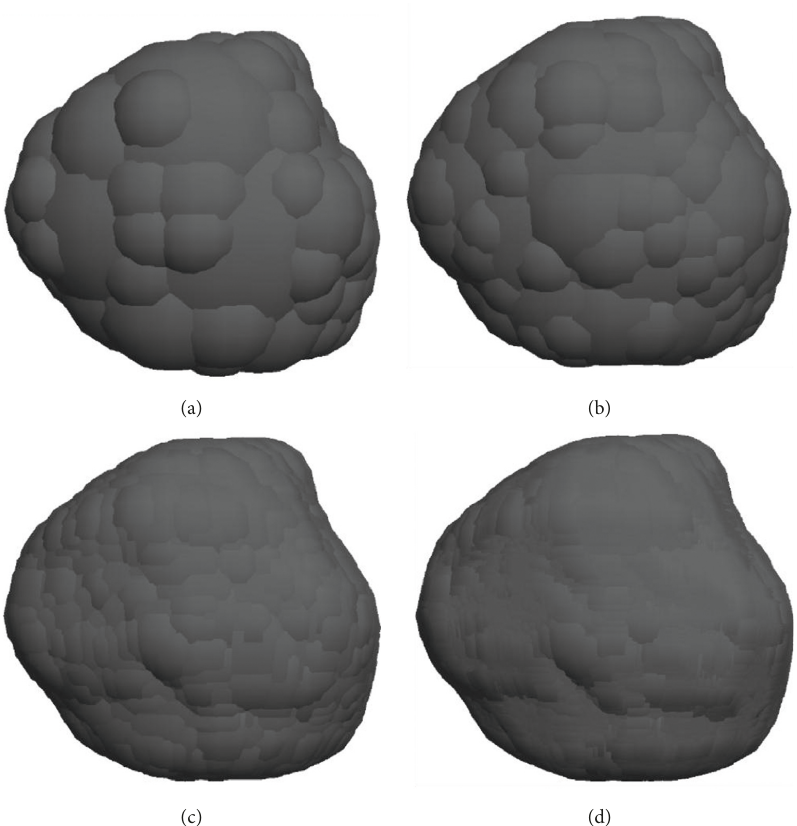
Figure 15: Construction of a three-dimensional particle model with different mesoscopic parameters. (a) F and (d) F d � 180.